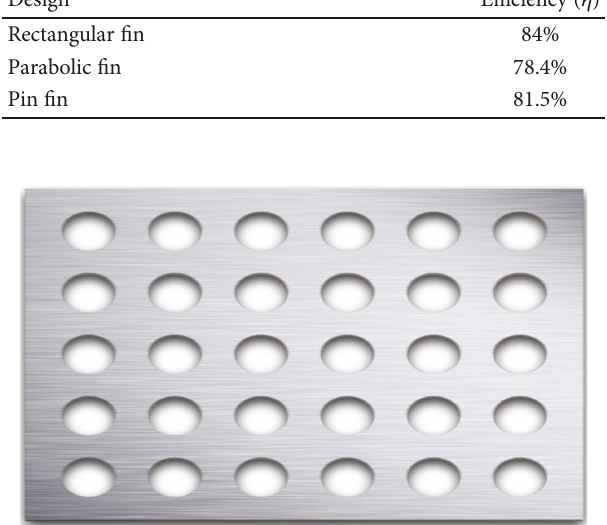
Figure 1: A perforated fi n that was attached to the backside of a PV panel to act as a heat sink and to reduce the PV panel ’ s